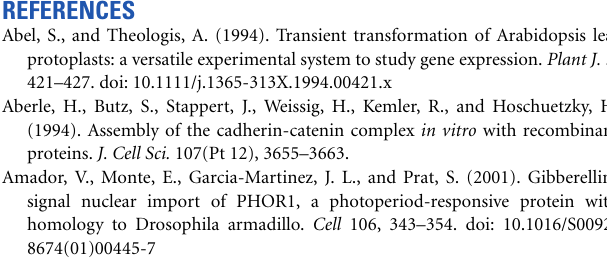
Figure S1 | Growth and development of Arabidopsis plants overexpressing GFP-AtPUB43 (cid:2) ARM 1–6 fusion proteins. Figure S2 | Phylogeny of PUB-ARM proteins of Arabidopsis, rice, poplar, and moss, as recovered by Bayesian analysis of the alignment covering 150 Proteins and 2683 amino acid positions. Figure S3 | Phylogeny of PUB-ARM proteins of Arabidopsis, rice, poplar, and moss, as recovered by Bayesian analysis of the alignment covering 150 Proteins and 210 amino acid positions. Table S1 | Primer pairs for amplification the respective open reading frames by